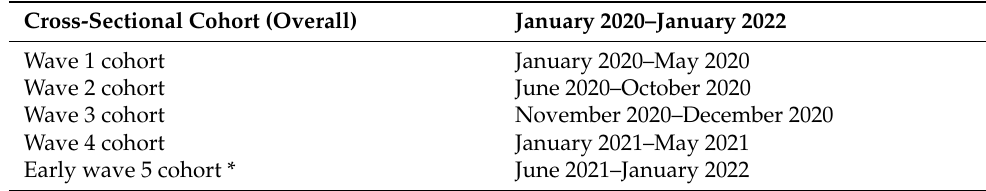
Table 1. Temporal Stratification of the Five Wave Cohorts. Cross-Sectional Cohort